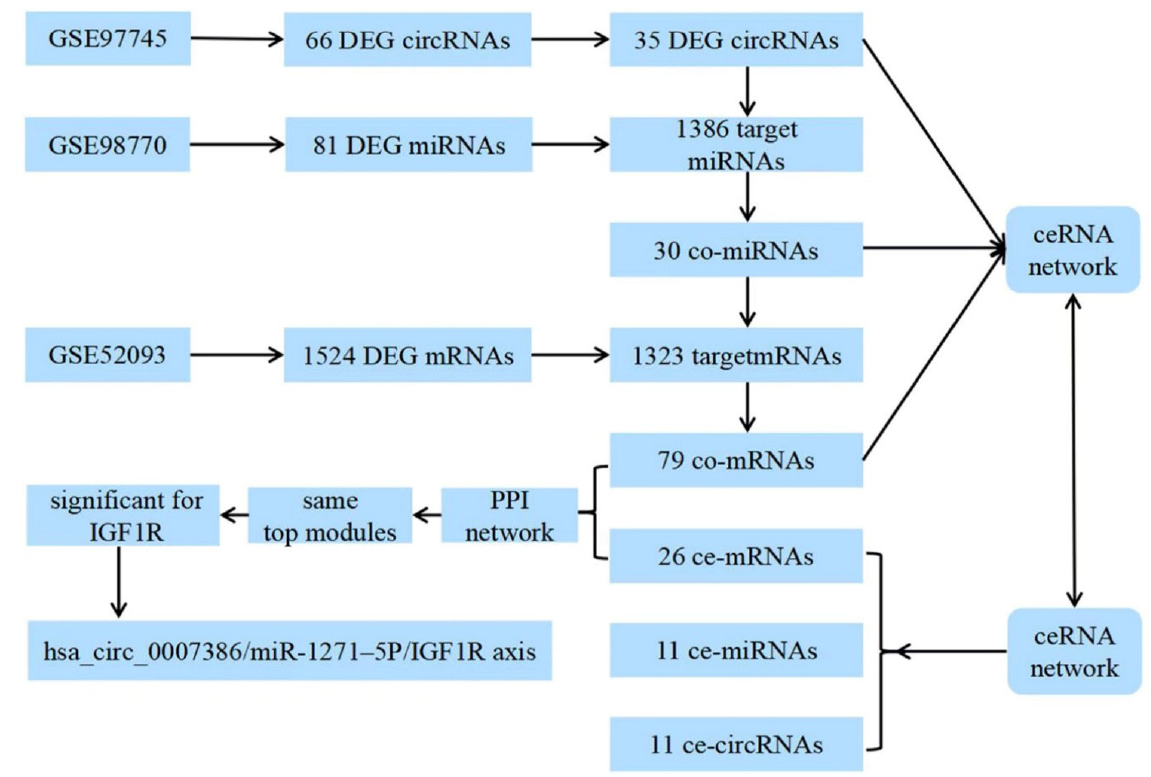
Figure 1. Diagram of ceRNA network construction.